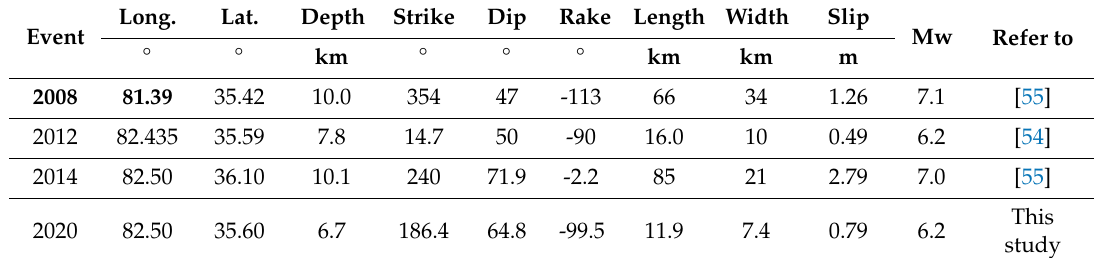
Table 4. The hypocentral and source parameters of the Mw > 6 earthquakes in the Yutian region after the 20 March 2008 Yutian earthquake. Note that the hypocentral parameters represent the center of the rectangle plane.